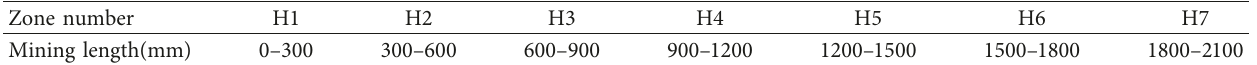
Figure 8: Fracture networks at the end of the mining process. Mining face: (a) 5-1; (b) 5-3. Table 10: Horizontal zone description.